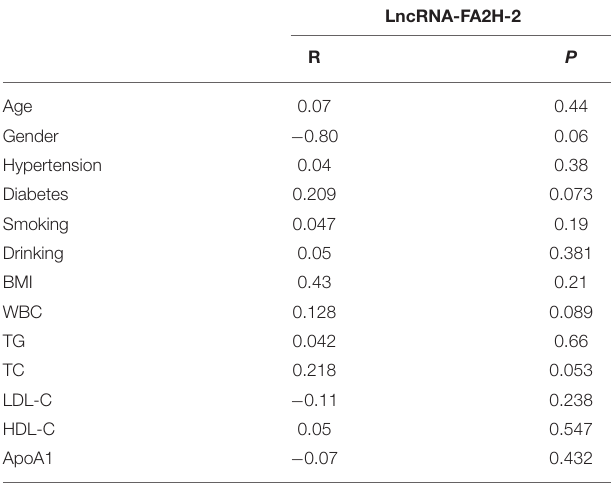
TABLE 7 | Correlation analysis of LncRNA-FA2H-2 and clinical characteristics.